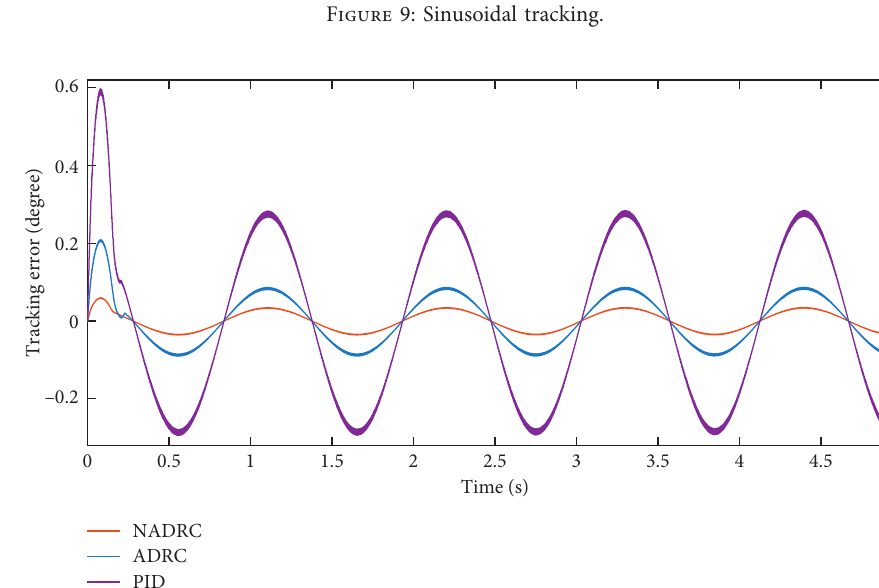
Figure 9: Sinusoidal tracking.